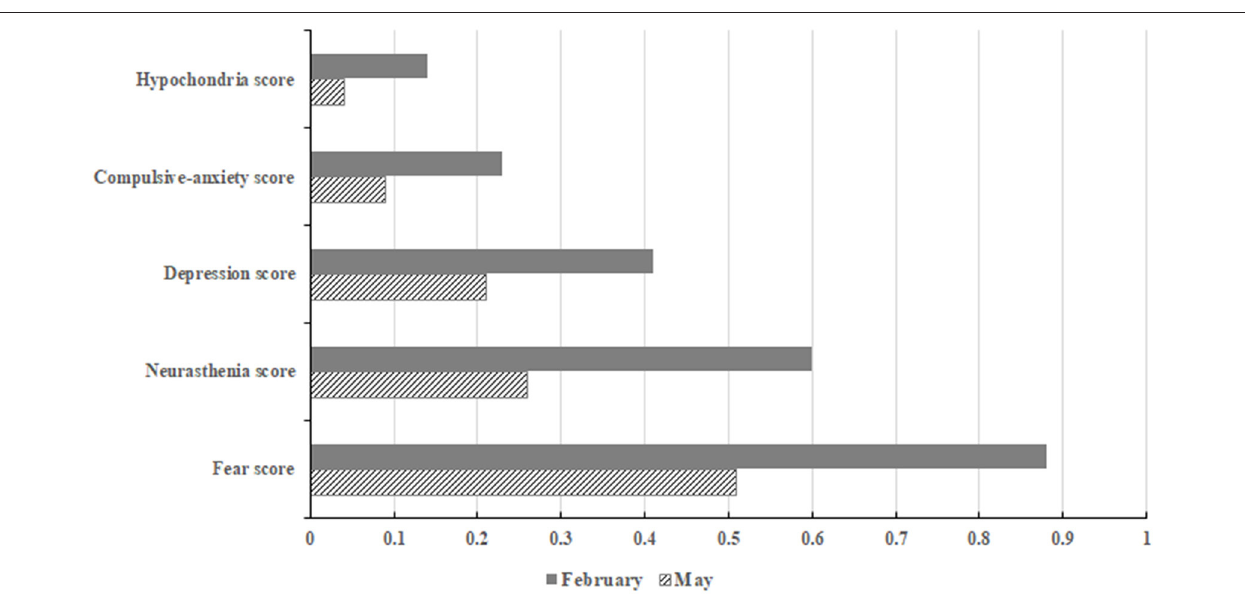
FIGURE 1 | Comparison of psychological scores between ART-treated women during the outbreak period and those during the control